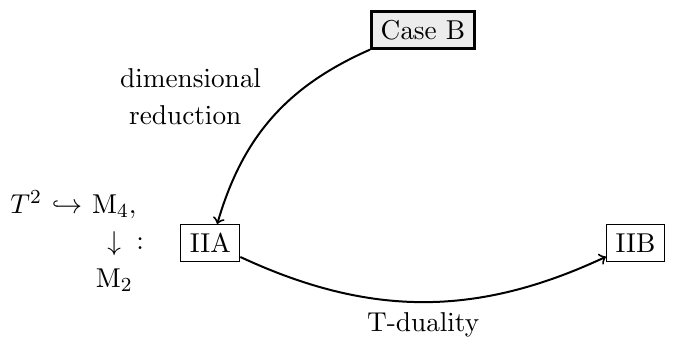
Figure 1 . Depiction of the chains of dualities leading to Mink 4 (cid:2) S 2 classes in type II with non equal spinor norm. The relative complexity of solutions at each step as one moves from M-theory to IIA to IIB can increase considerably, with speci(cid:12)c choices of U(1) the duality is performed on. However all solutions are governed by the M5